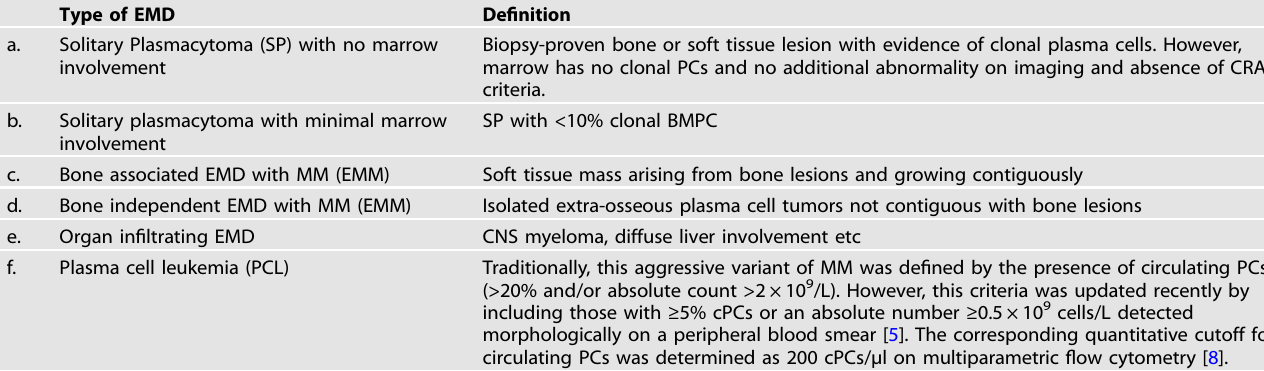
Table 1. Classi fi cation of